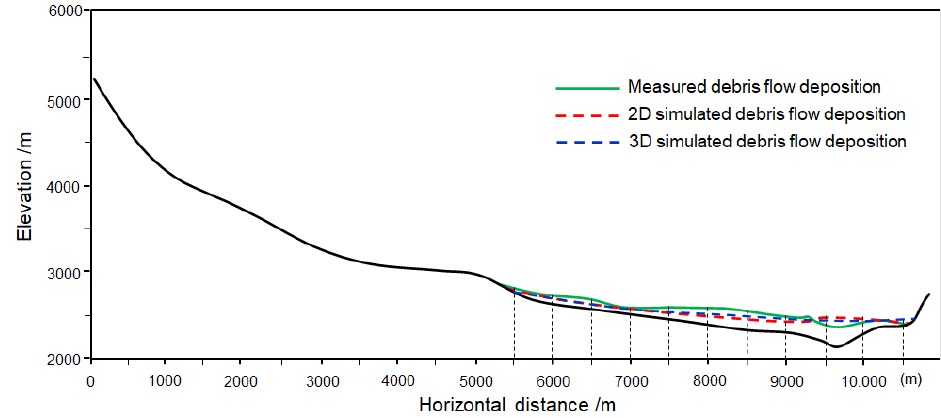
Figure 8. Velocity–time history curves of different parts of the debris flow.